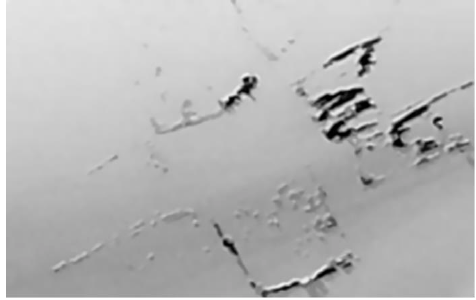
Figure 8. Result after using the NL-means filter.